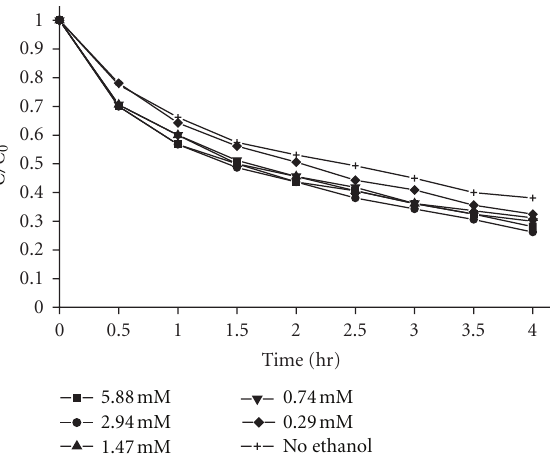
Figure 5: E ff ect of initial concentration on the photocatalytic